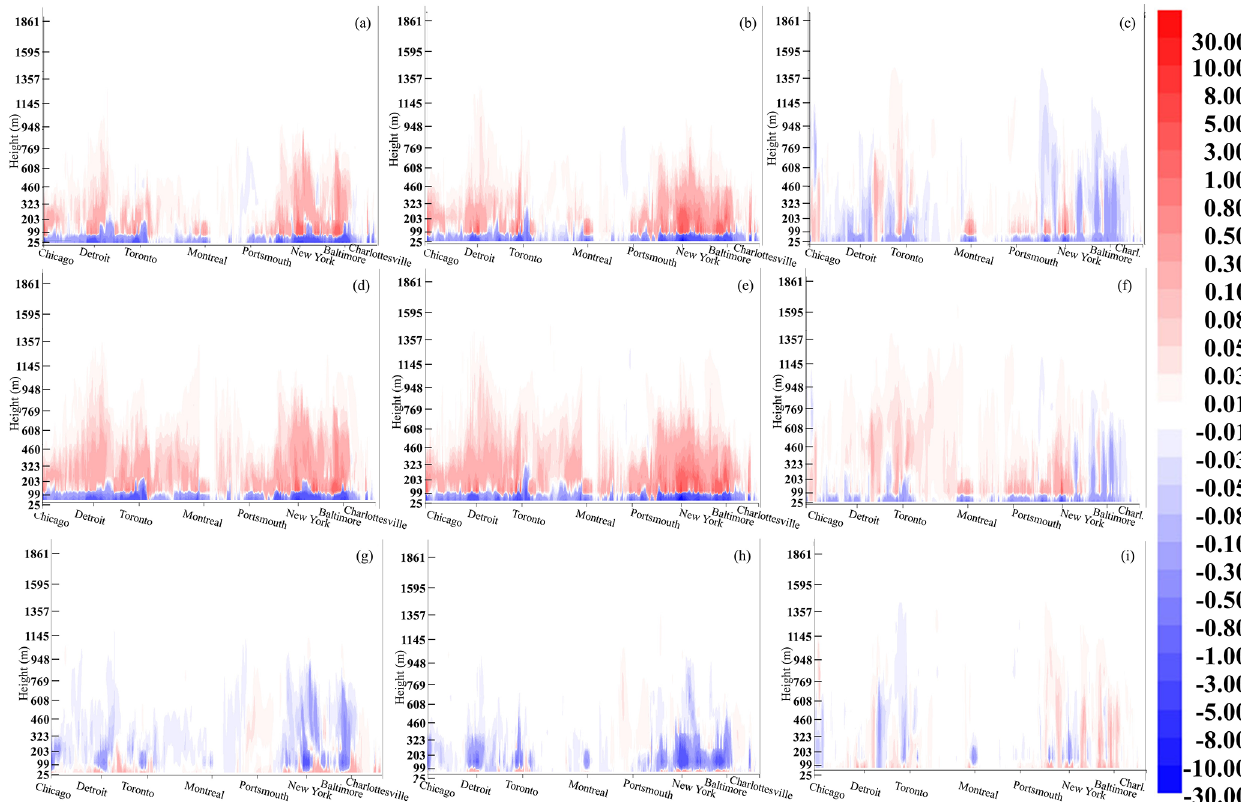
Figure 11. Vertical cross sections of concentration differences between major eastern North American cities, January 2016; panels arranged as in Fig. 10. Vertical coordinate: unitless hybrid, the top of the scale is approximately 2km. Units: (cid:49) NO 2 , (cid:49) O 3 – ppbv; (cid:49) PM 2 . 5 – µgm − 3